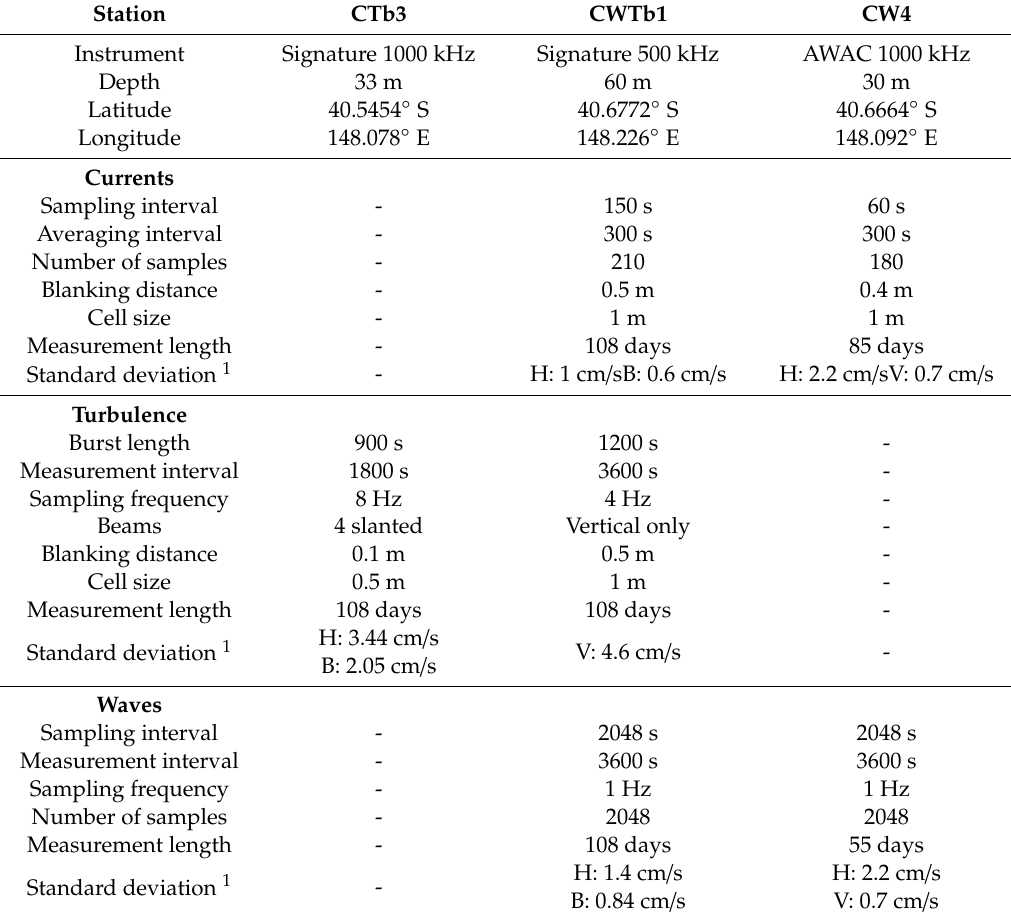
Table 1. Summary of instruments configurations and deployment